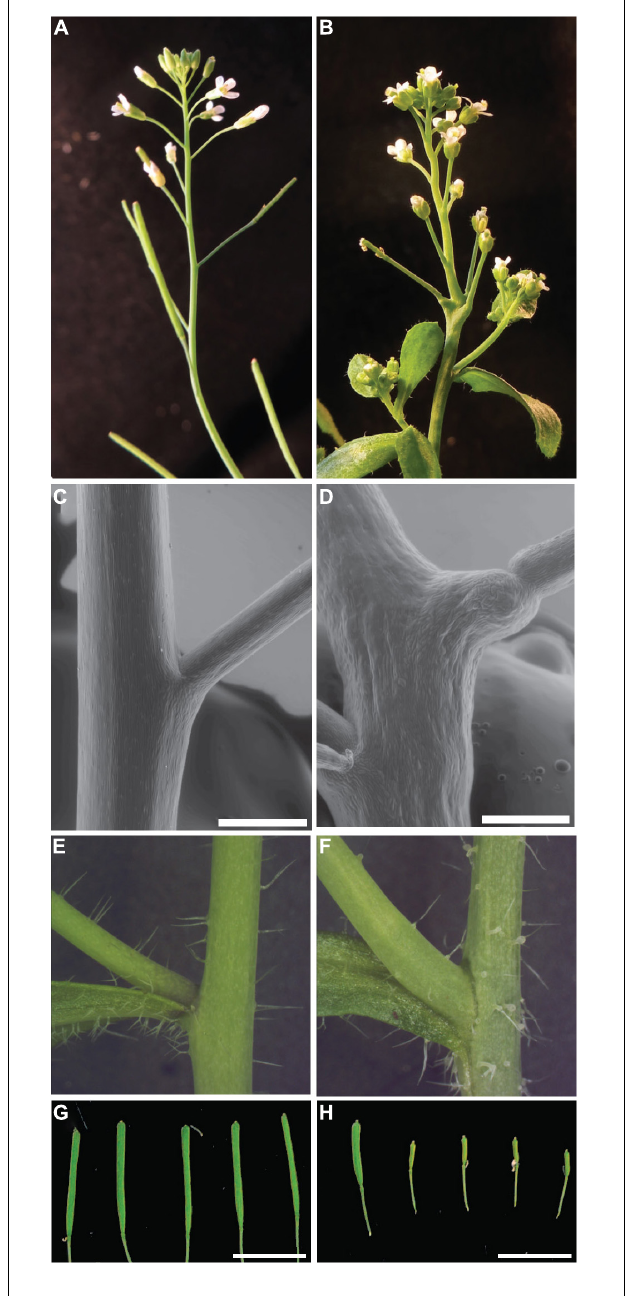
FIGURE 1 | bumpy stem inflorescence phenotypes. Normal Col-0 inflorescences exhibit spiral phyllotaxy with flowers separated from each other along the inflorescence (A) . bst flowers are found in clusters on the inflorescence and exhibit disrupted phyllotactic patterning (B) . The boundary between the pedicel and stem is flush with the side of the stem in Col-0 plants (C) . In bst mutants the notch defining the boundary is displaced, occurring at the tip of ectopic stem tissue that extends from the side of the stem (D) . No displacement is observed at the boundary between the main stem and axillary stems (E,F) . Compared to Col-0 trichomes (E) , bst trichomes have swollen bases (F) . Wild-type Ler plants are fertile and have filled and expanded siliques (G) . bst mutants in a Ler background are semi sterile, resulting in short siliques containing few seeds (left silique) and many sterile unexpanded siliques (right siliques) (H) . Scale bars are 0.5 mm in C,D and 1 mm in G,H